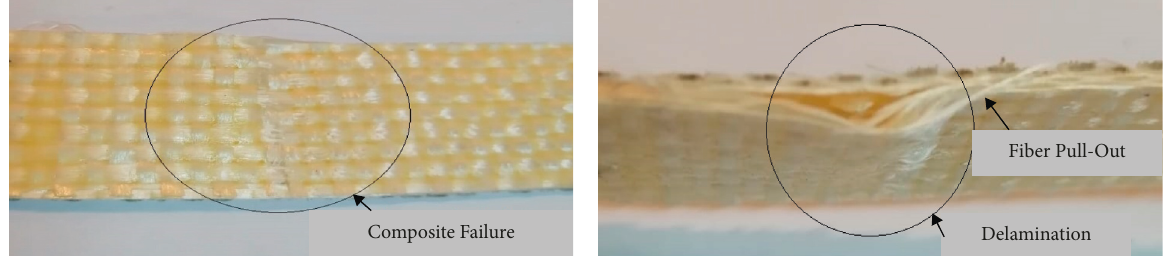
Figure 4: Samples after tensile test showing delamination and fiber pull out.